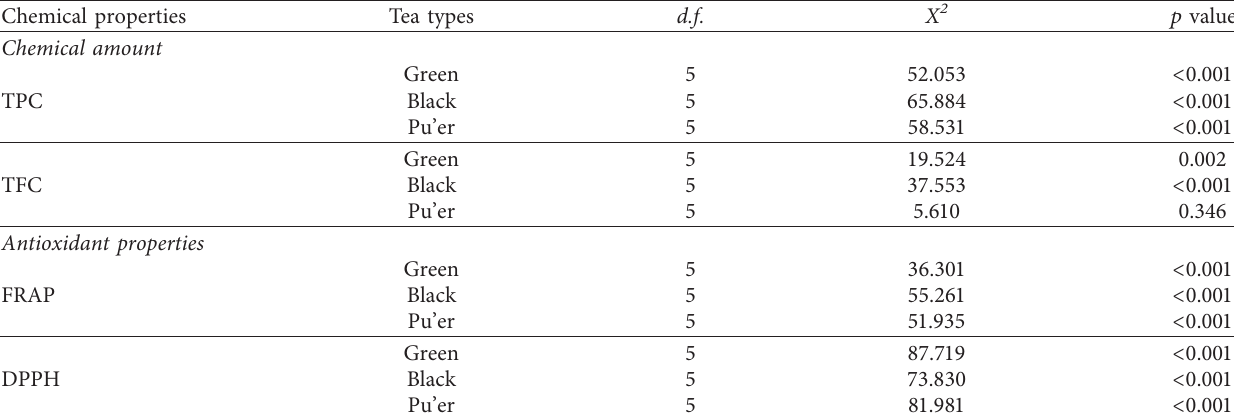
Table 1: The effect of fermentation time on the chemical profile and antioxidant activity of kombucha beverages produced using green, black, and pu’er teas.